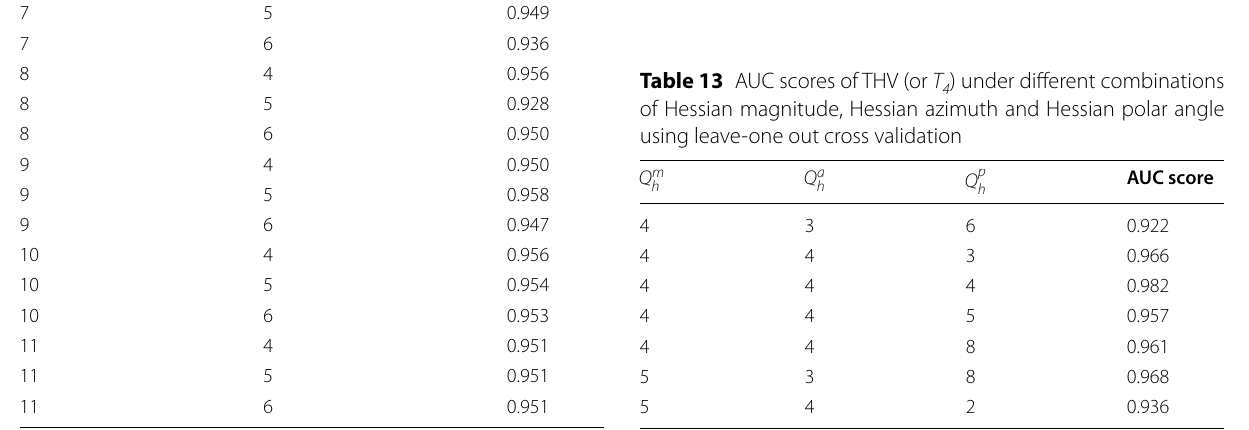
) under different combinations 4